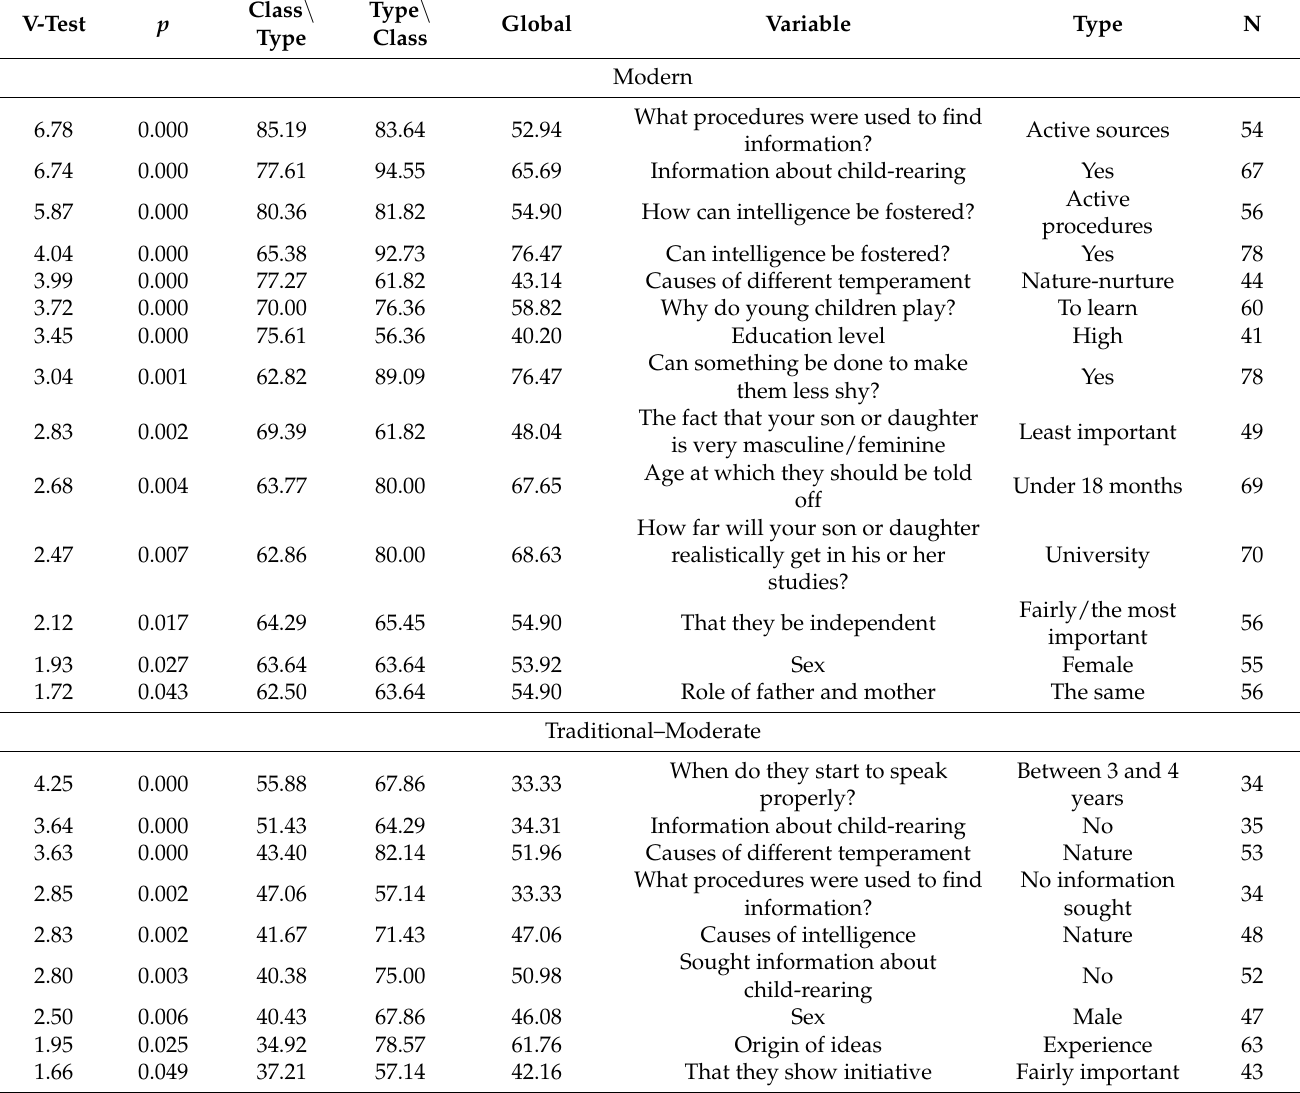
Table 2. Response types for the different classes regarding ideas about childhood (Type/Class >